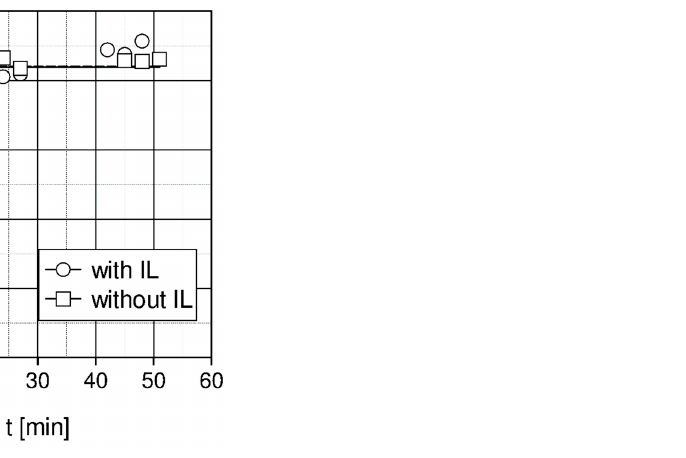
Figure 4. Comparison of measured CO 2 concentration for adsorption on pelletized activated carbon (4 mm) bed before and after its impregnation with ionic liquid [Emin][Ac] ( 1 bar, temperature 20 °C, Cin = 10% vol. and gas flow rate Vg = 750 L/h).